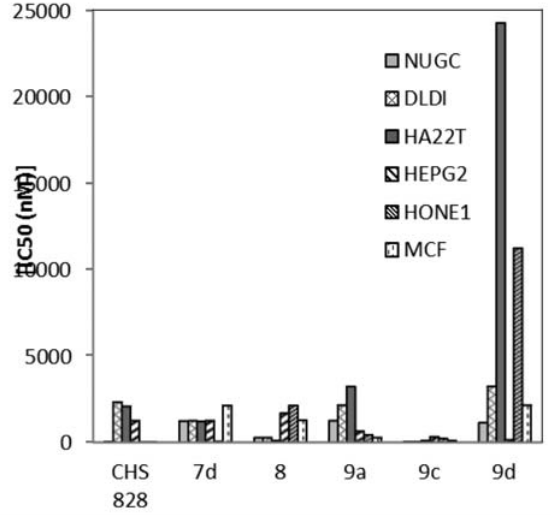
Figure 4 . Cytotoxicity of 7d , 8 , 9a , 9c , 9d and CHS 828 against NUGC (gastric cancer); DLDI (colon cancer); HA22T (liver can- cer); HEPG2 (liver cancer); HONE1 (nasopharyngeal carcinoma); MCF (breast